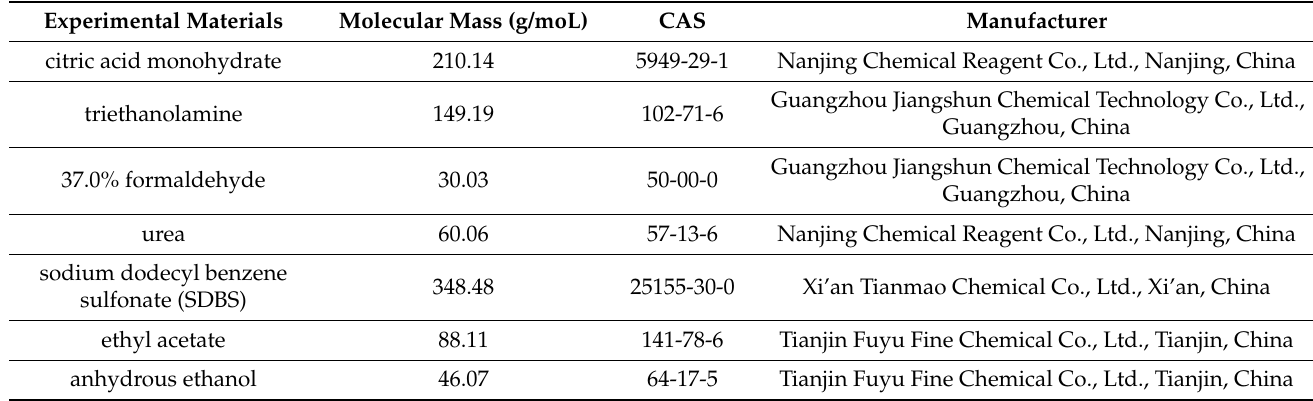
Table 1. Chemical reagent information in experiment.